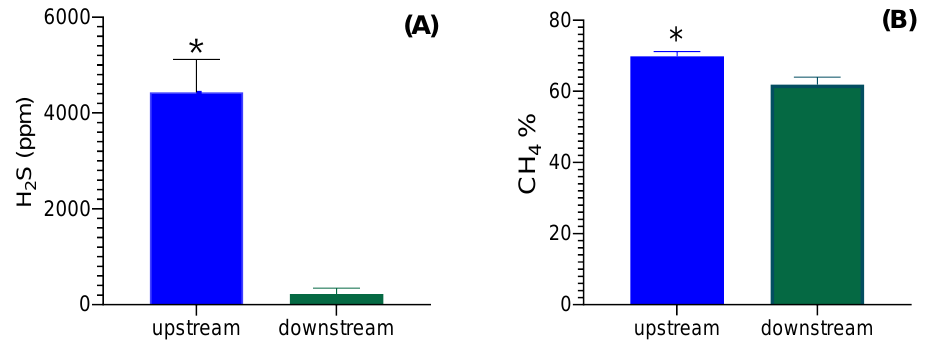
Figure 8. Graphic presentation of the comparison between the mean values of each parameter: ( A ) H 2 S, ( B ) CH 4 (upstream and downstream). * The two means in the same graph are significantly different ( t -test, p < 0.05).